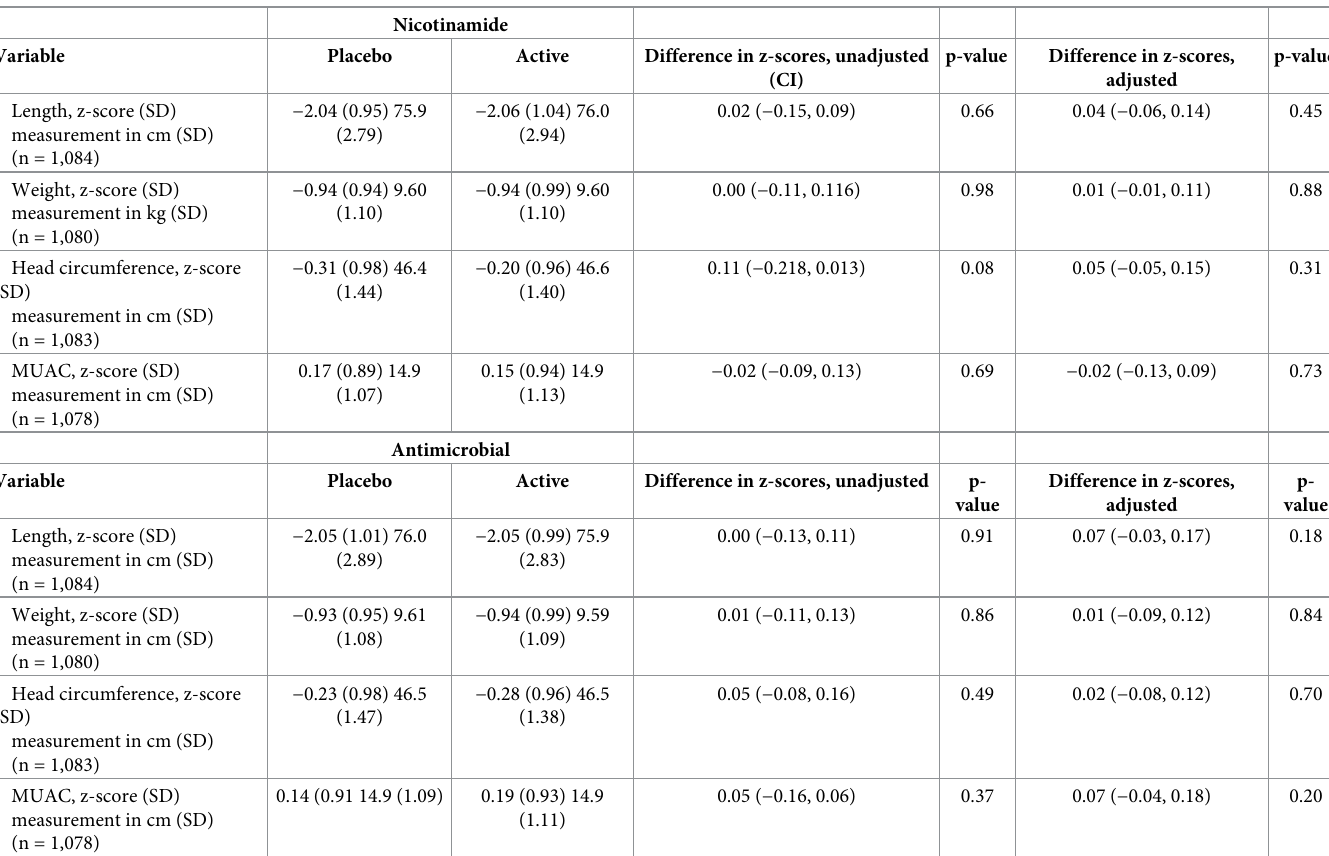
Table 2. The 18-month anthropometry outcomes from unadjusted and adjusted analyses for the modified intention-to-treat analysis � .